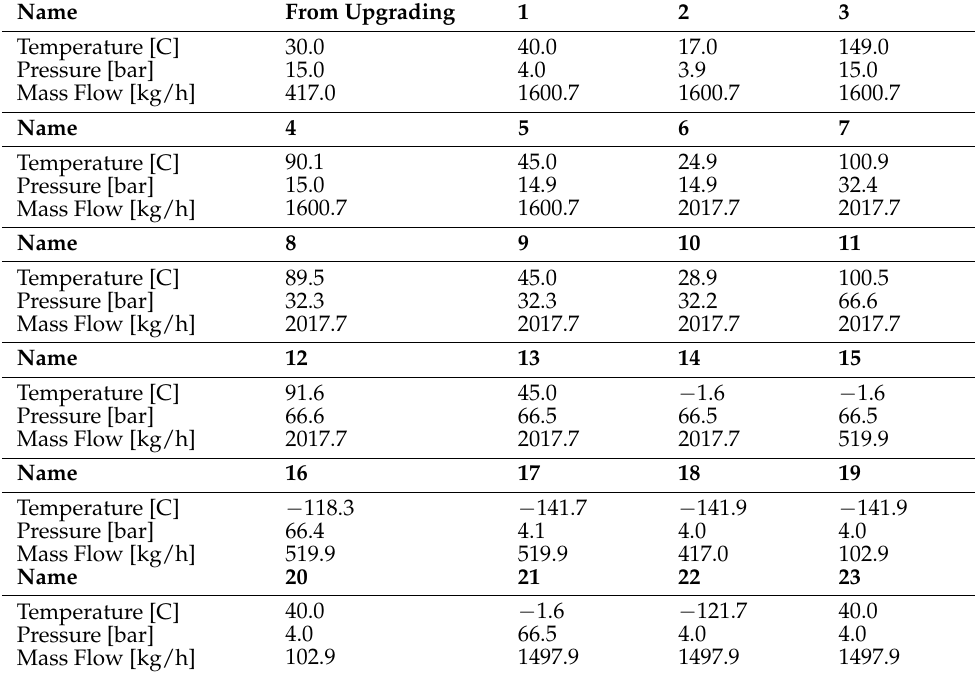
Table A10. States of the biomethane flows in AC-2.